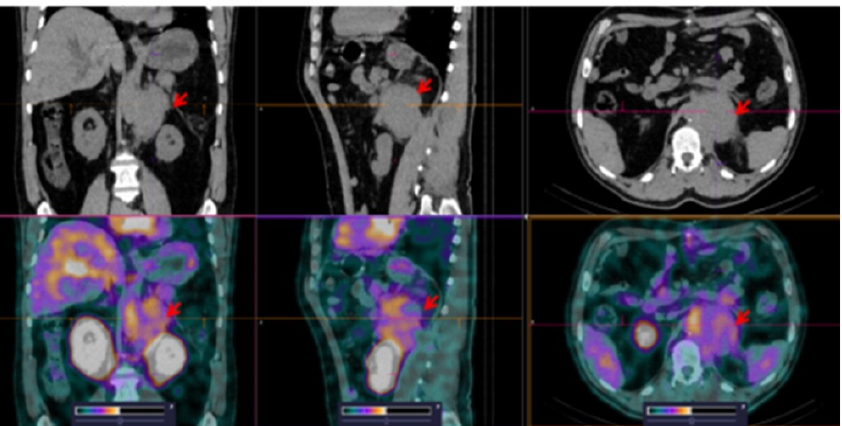
Figure 6. SPECT/CT images of patient 1 at 2 h after injection of [ 99m Tc]Tc-TG. Elevated [ 99m Tc]Tc-TG uptake in the retroperitoneal tumor (SUVmax = 3.92) is visualized (arrows). The upper setting of the scale window (40% of the maximum number) was adjusted to visualize the lesion.